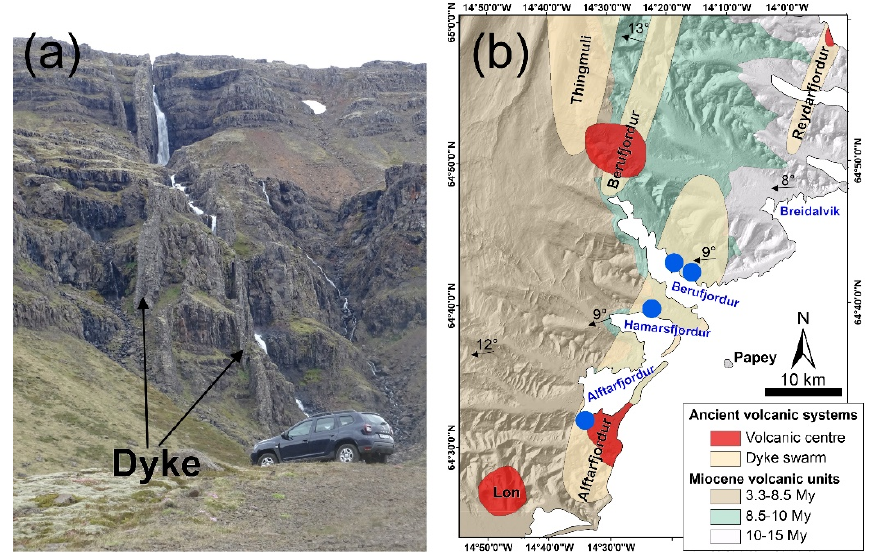
Figure 2. ( a ) Example of typical dykes cutting the Tertiary basalt formation in the Berufjordur valley, car for scale. ( b ) Detailed map of a portion of eastern Iceland, showing 4 out of 5 sites presented in this study, which belong to the Alftarfjordur ancient volcanic system; lava tilting is shown by black arrows; the figure is adapted from Paquet et al.